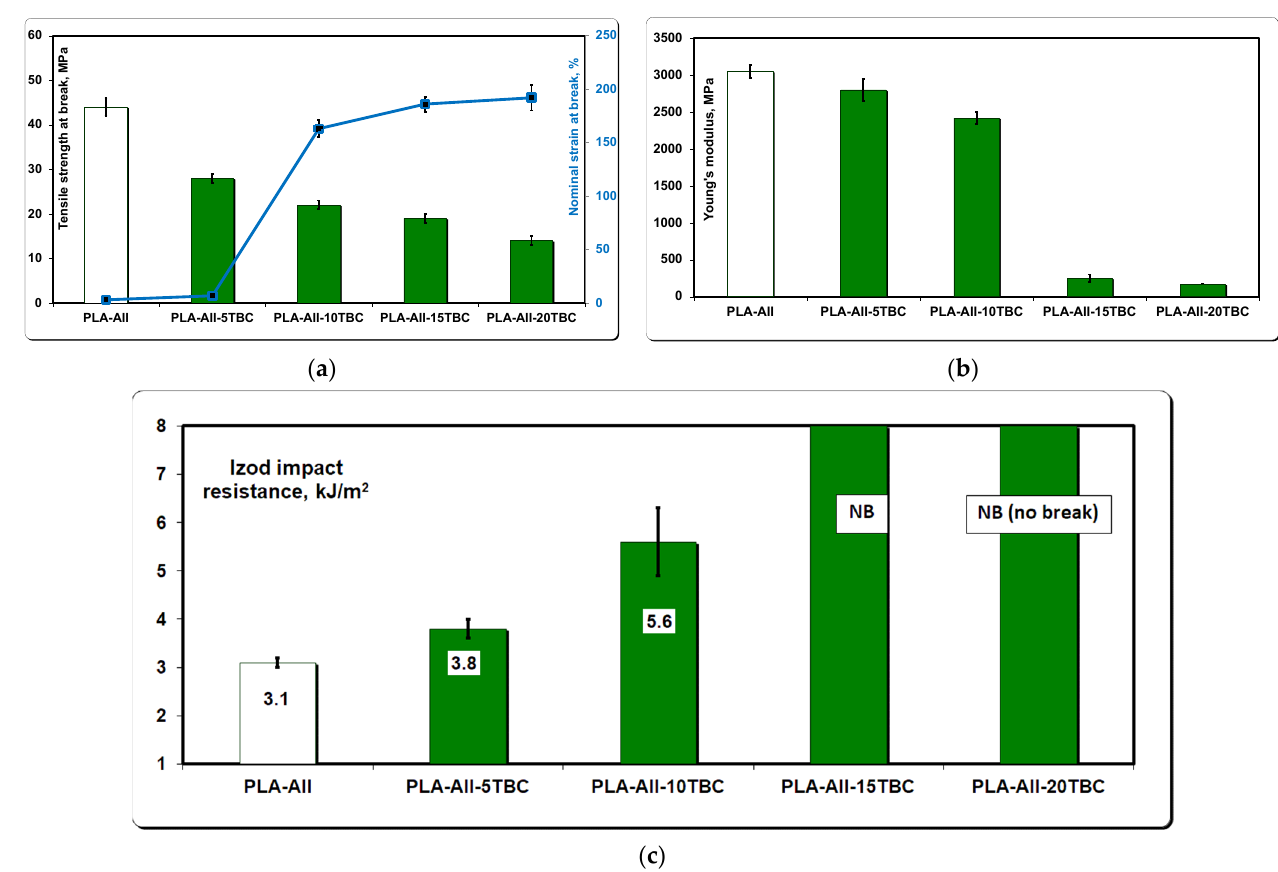
Figure 8. ( a – c ) Comparative mechanical properties of PLA–AII and of PLA–AII–TBC composites with different plasticizer percentage: ( a ) Tensile strength and strain at break; ( b ) Evolution of Young’s modulus; ( c ) Impact resistance (Izod) on notched specimens.